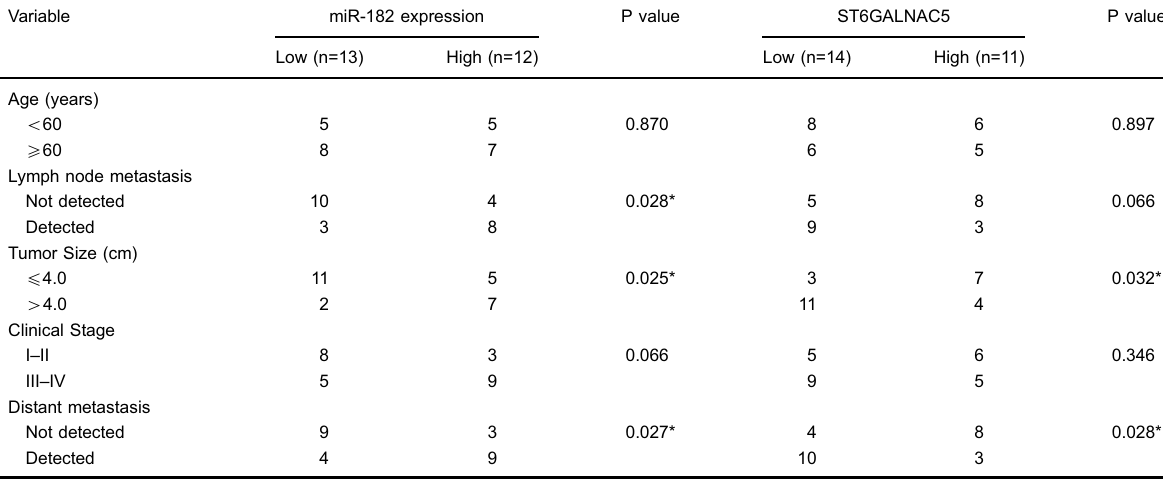
Table 2. Correlation between the expression of miR-182, ST6GALNAC5, and clinicopathological factors of patients with prostate cancer (n=25).